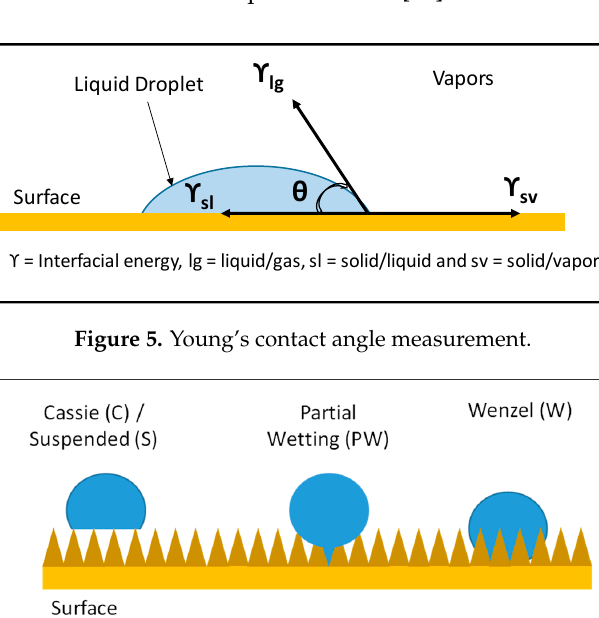
Figure 6. Different states of liquid droplets under different circumstances.